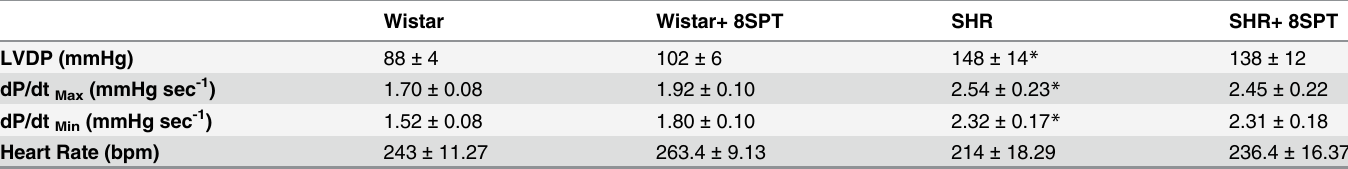
Abbreviations: LVDP, Left Ventricular Developed Pressure; dP/dt max/min, Ventricle max/min